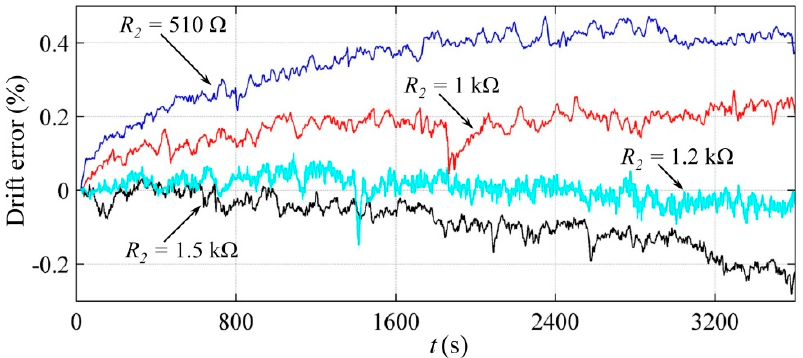
Figure 9. The time plots of the drift in the resulting frequency measured from the circuit in Figure 3 at Vcc = 2.5 V, σ = 1.15 MPa using Equation (19) for error assessment. The offset resistance R 1 was fixed at 510 Ω for all tests. The offset resistance R 2 was changed between trials according to the arrow marks.